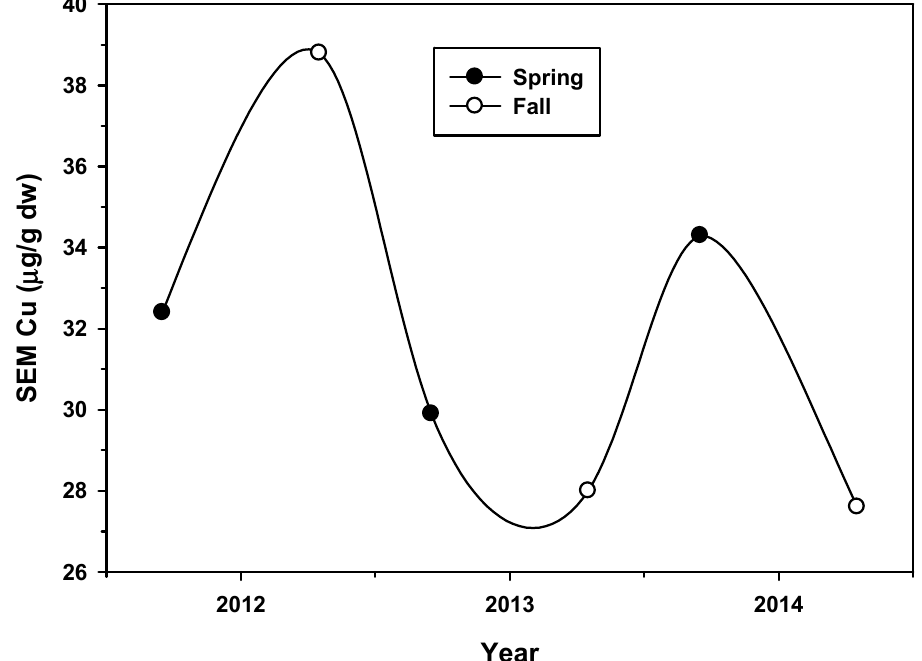
Figure 7. SEM copper concentrations (µg/g dry wt) from spring and fall sediment sampling at Cache Slough site CS-06 for the years 2012, 2013 and 2014.